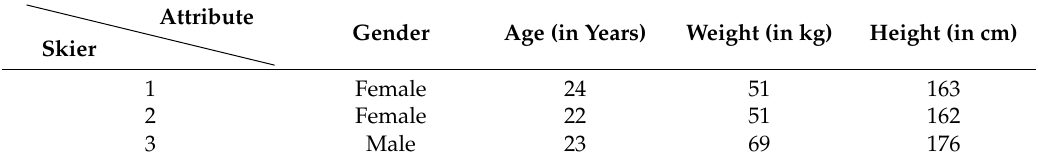
Table 2. General characteristics of the three professional skiers that participated in the study. Attribute Gender Age (in Years) Weight (in kg) Height (in cm) Skier Female